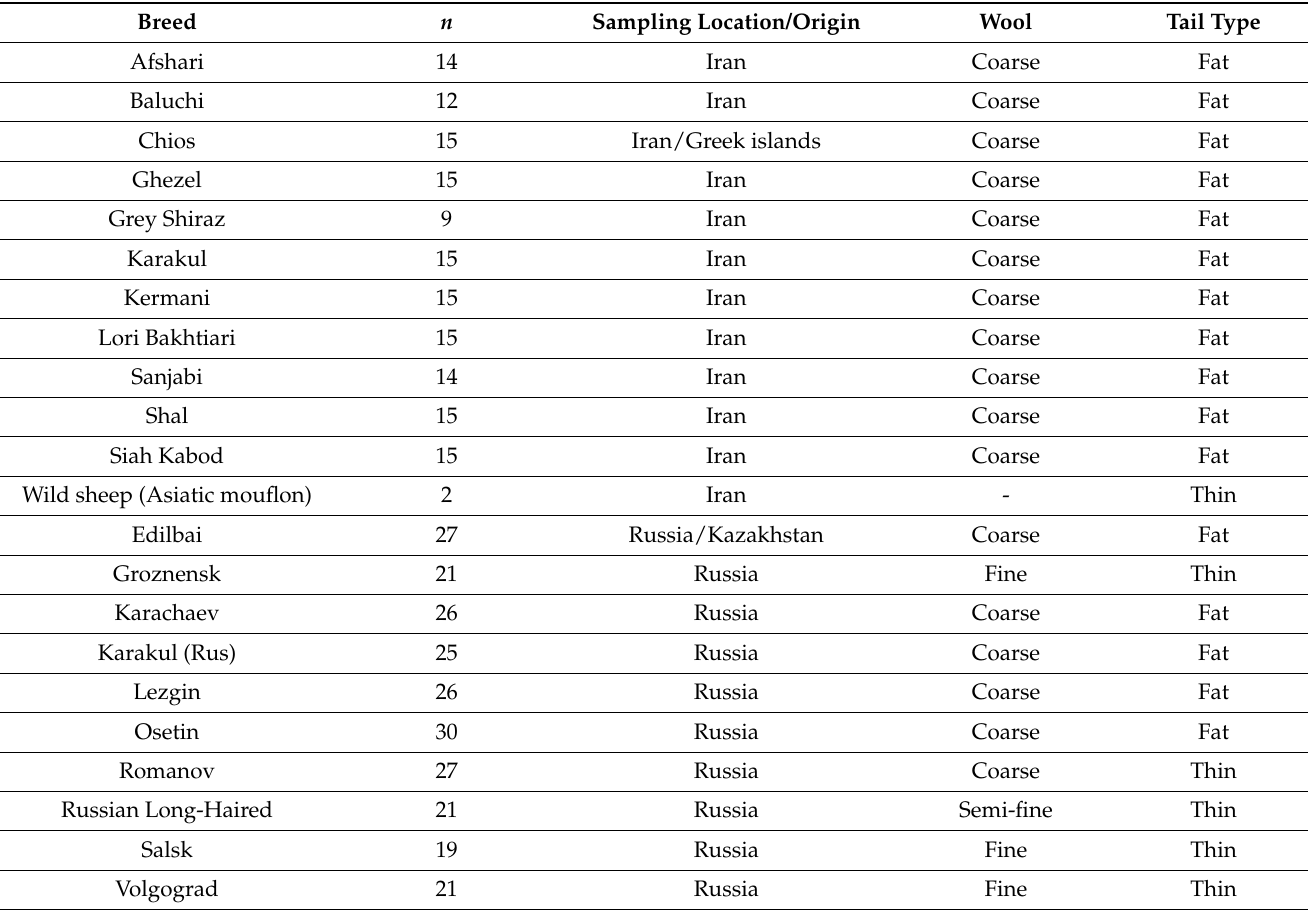
Table 1. Short description of the Iranian and Russian sheep populations used in this study. Breed n Sampling Location/Origin Wool Tail